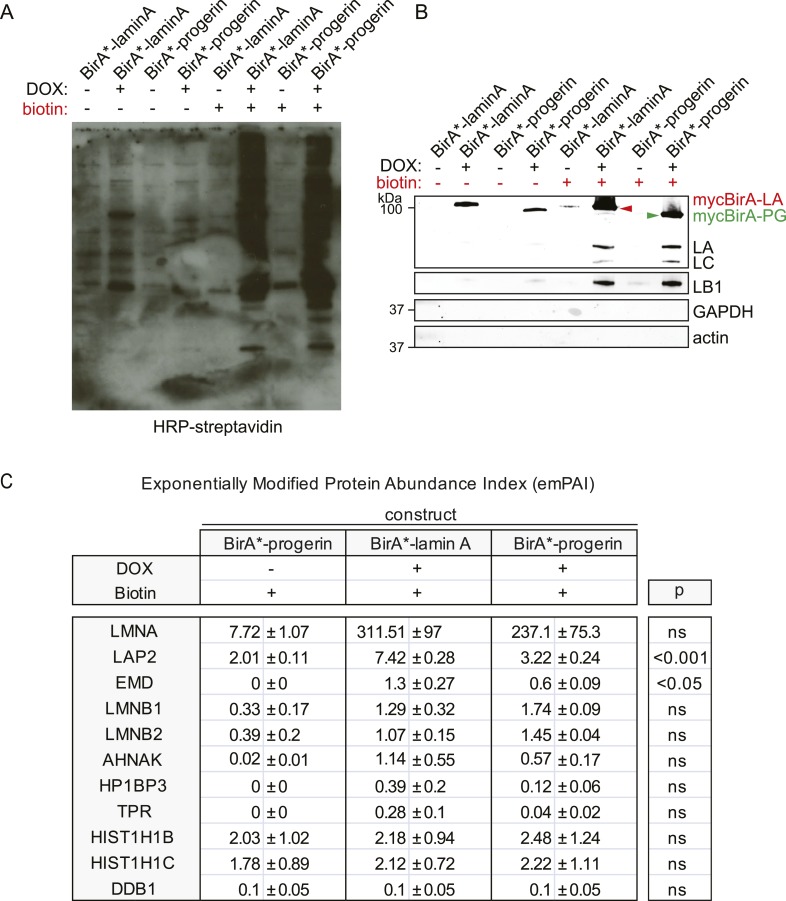
BirA*-dependent biotinylation of proteins in human fibroblasts, control experiments and protein list.(A) Western blot showing specific biotinylation of proteins by BirA*-laminA and BirA*-progerin fusion proteins, upon DOX induced expression and in the presence of biotin. Conditions are indicated above each lane. Staining: HRP-streptavidin. (B) Western blot analysis of pulled down biotinylated proteins (prior to mass spectrometry analysis). Antibodies: lamin A/C antibody recognizes both endogenous lamin A (LA), lamin C (LC) and fusion constructs BirA*-lamin A and BirA*-progerin, lamin B1 (LB1), GAPDH and actin. (C) Comparative interactome of lamin A and progerin after BioID assay using the exponentially modified protein abundance index (emPAI). emPAI index quantifies the abundance of a protein identified by mass spectrometry in a protein mixture. DOX untreated cells in the presence of biotin were used as negative controls accounting for endogenous biotinylation. Upper panel: top row: experimental conditions (±doxycyclin) and expressed constructs (BirA*-lamin A or BirA*-progerin). Lower panel (shaded row): list of proteins identified by mass spectrometry and their respective emPAI index. p-values and SEM from three independent experiments are indicated (one-way ANOVA with Tukey's post-test).